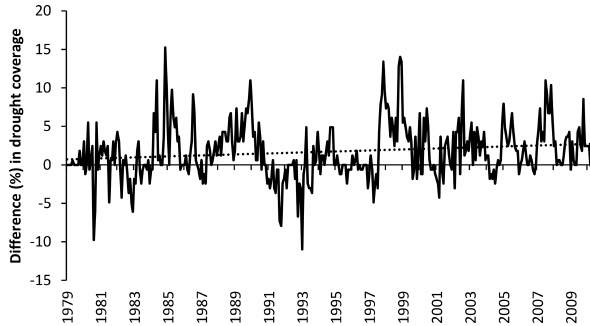
Figure 2. SPEI-SPI difference in percentage area in drought. The dashed line indicates the linear trend fitted to the time